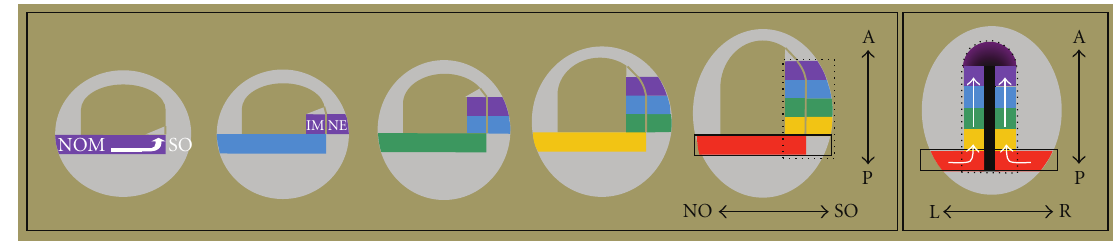
Figure 2: A developmental principle: time-space translation. The figure illustrates how temporally collinear Hox expression (in vertebrate gastrula mesoderm) is translated to a spatially collinear axial Hox pattern (in axial mesoderm and the neural plate). For a detailed explanation, see Durston et al [5,